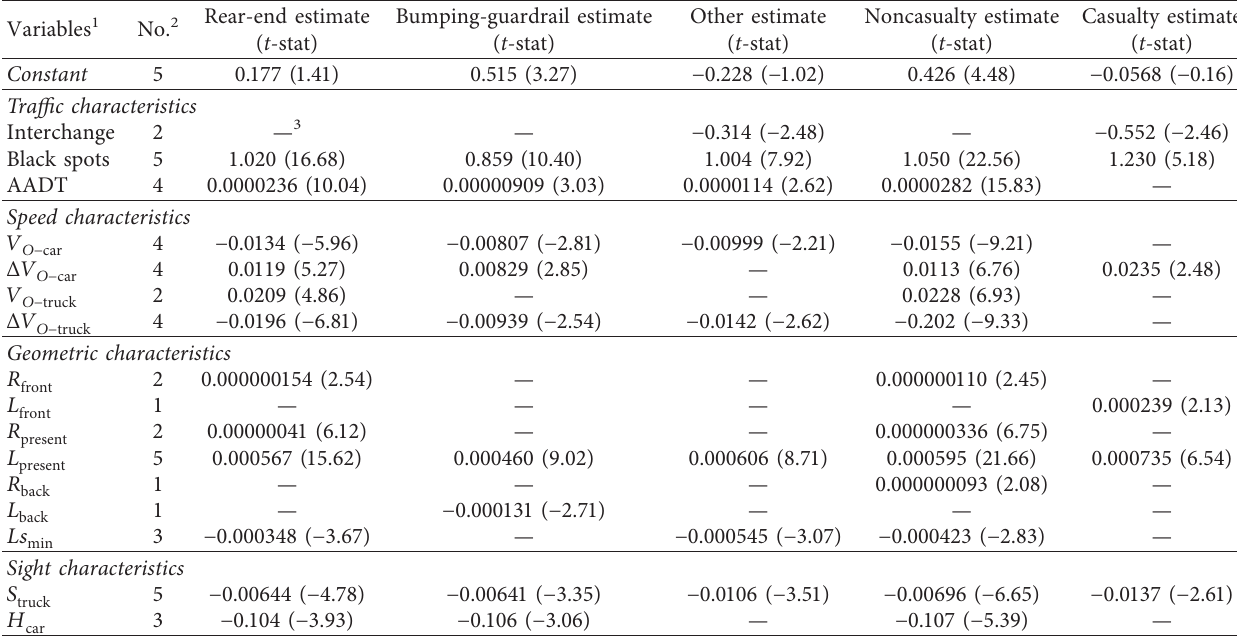
Table 10: Zero-inflated multivariate Poisson model estimation